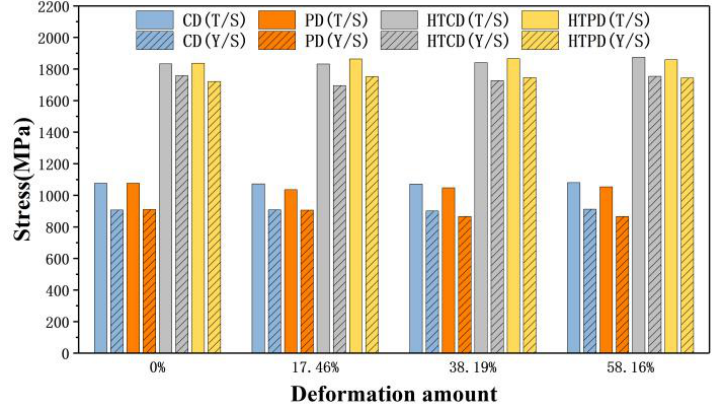
Figure 13. The tensile strength and yield strength of C250 after deformation and heat treatment.